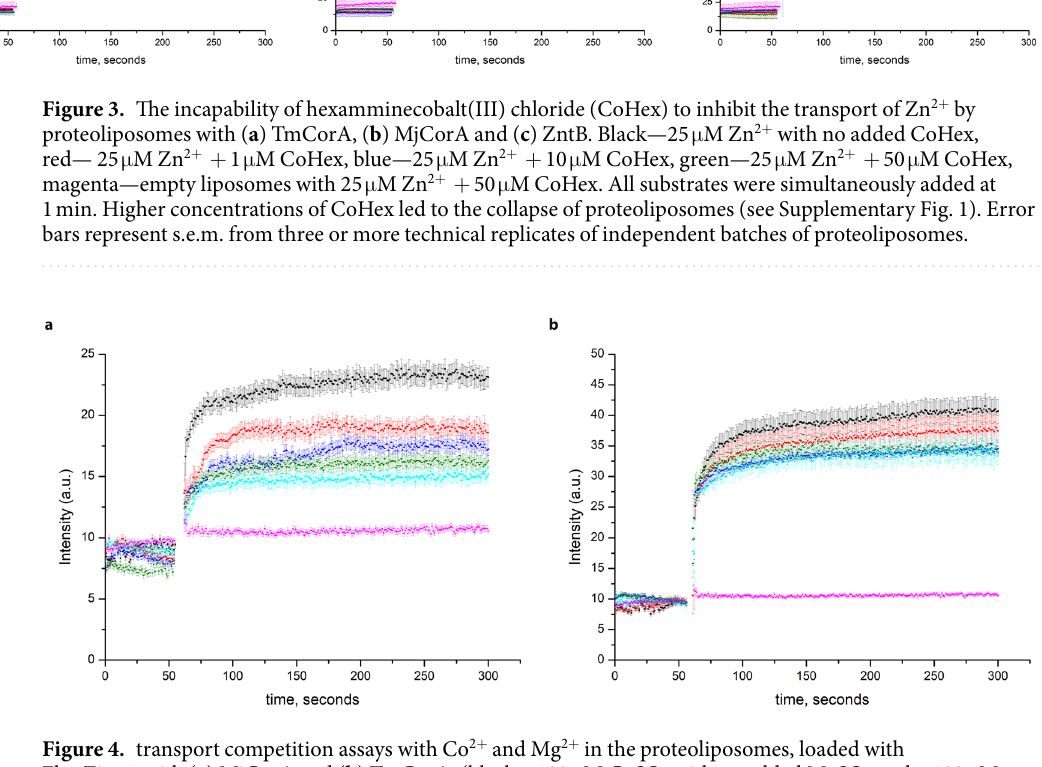
Figure 4. transport competition assays with Co 2 + and Mg 2 + in the proteoliposomes, loaded with FluoZin-1, with ( a ) MjCorA and ( b ) TmCorA, (black—100 μ M CoSO 4 with no added MgSO 4 , red—100 μ M CoSO + 1000 μ M MgSO μ M CoSO + 1000 μ M 4 4 , magenta—empty liposomes with 100 4 MgSO 4 ). All substrates were simultaneously added at 1 min. Error bars represent s.e.m. from three or more technical replicates of independent batches of